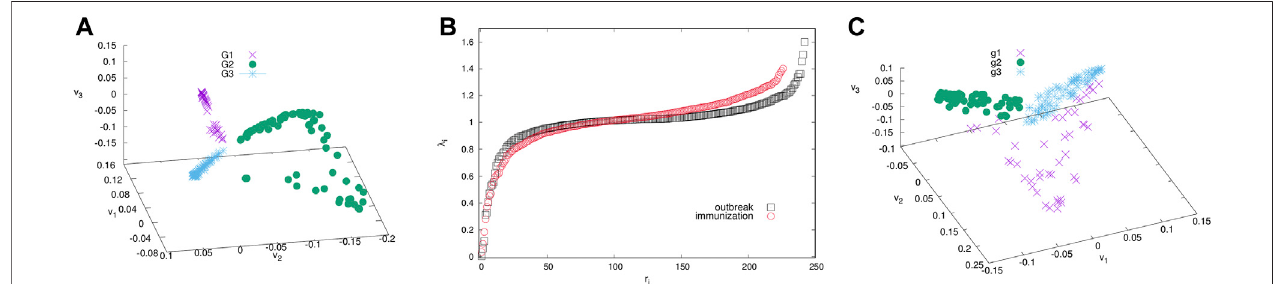
FIGURE 4 | The ranking of eigenvalues of the normalised Laplacian for the outbreak and immunisation networks (B) . Scatter plots of the eigenvectors v 1 , v 2 , v 3 correspondingtothethreesmallestnon-zeroeigenvaluesfortheoutbreak (A) andimmunisationperiodnetworks (C) .Branchesindicatedbydifferentcoloursidentifythe communities (groups) of nodes of the corresponding network in Figure 3 .